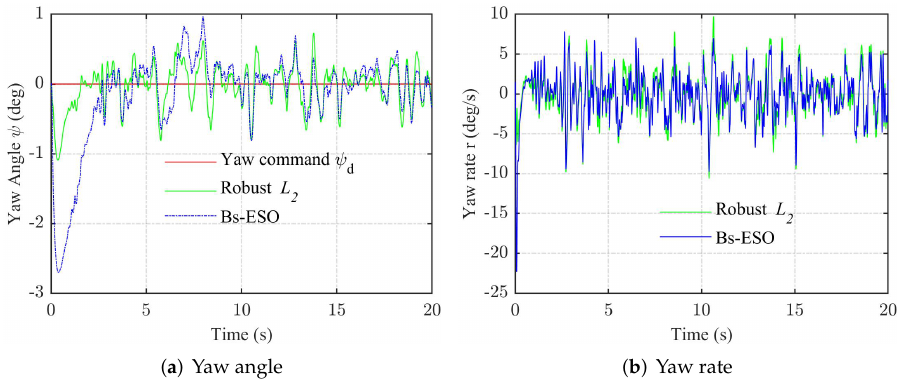
Figure 12. Yaw stability performance under wind turbulence.